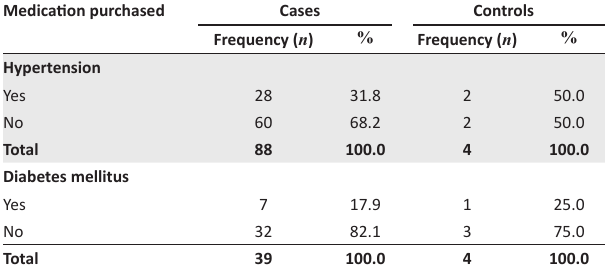
TABLE 3: Summary of participants’ ability to purchase medications.